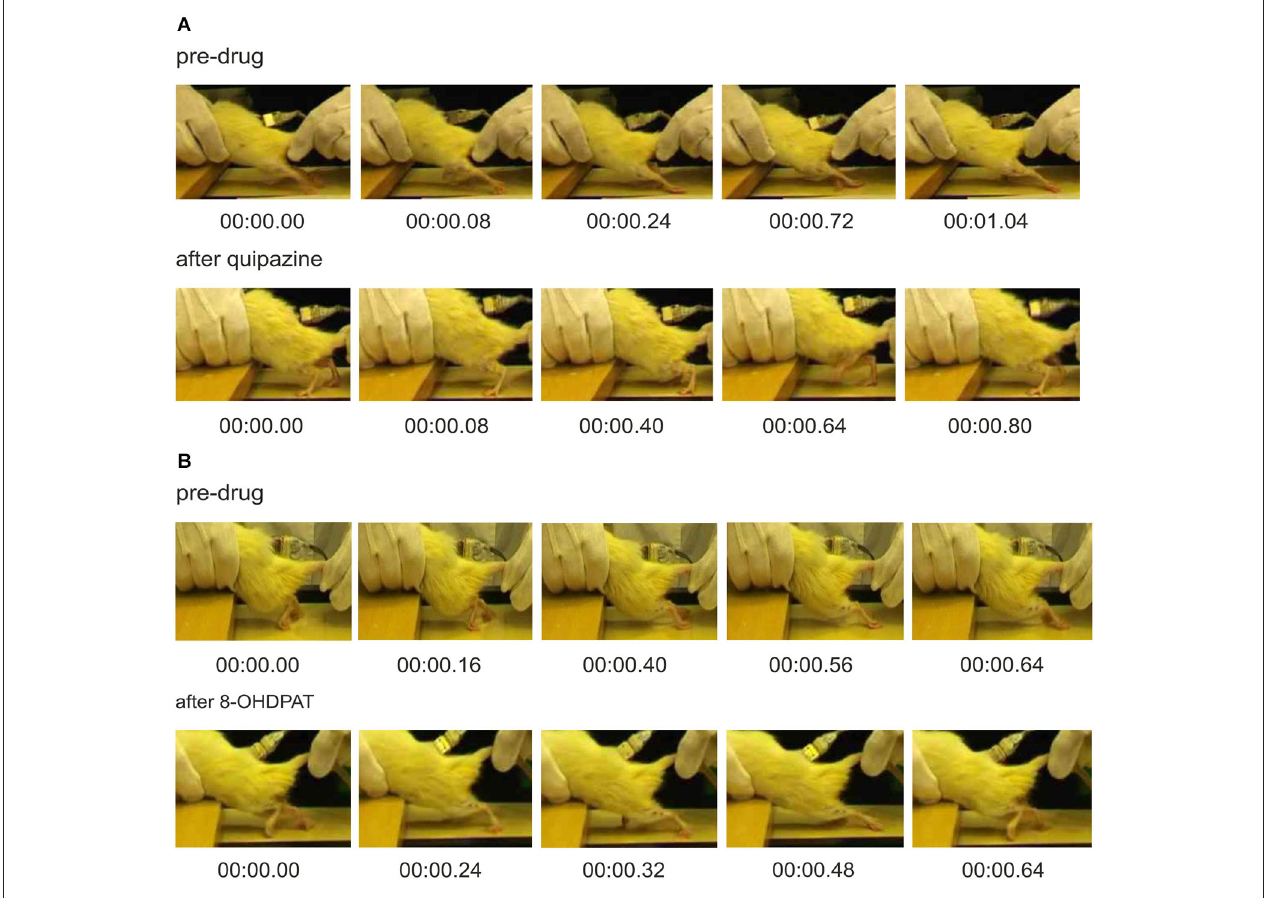
are evident after application of either drug. However, after quipazine application, spinal rats present better body weight support ( A , lower panel) in comparison to that after 8-OHDPAT ( B , lower panel) where the hindlimbs remain extended behind the